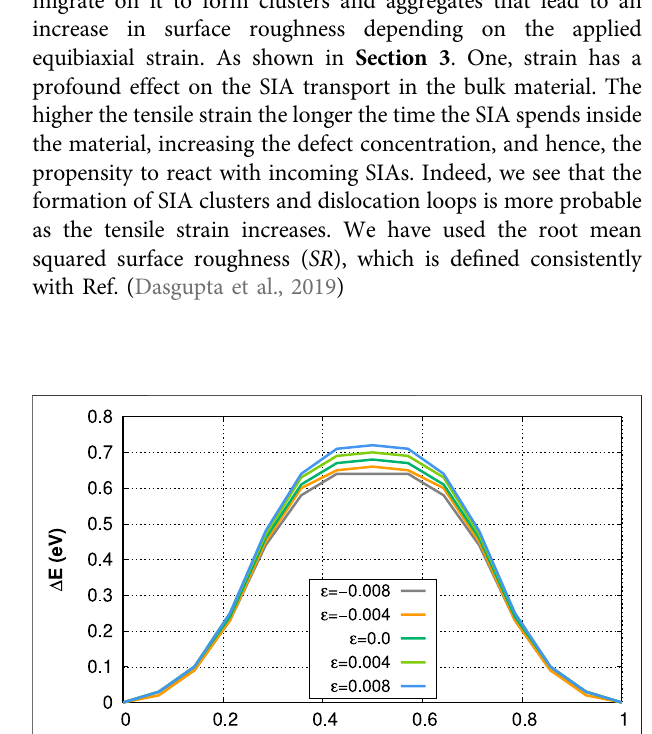
Frontiers in Materials |